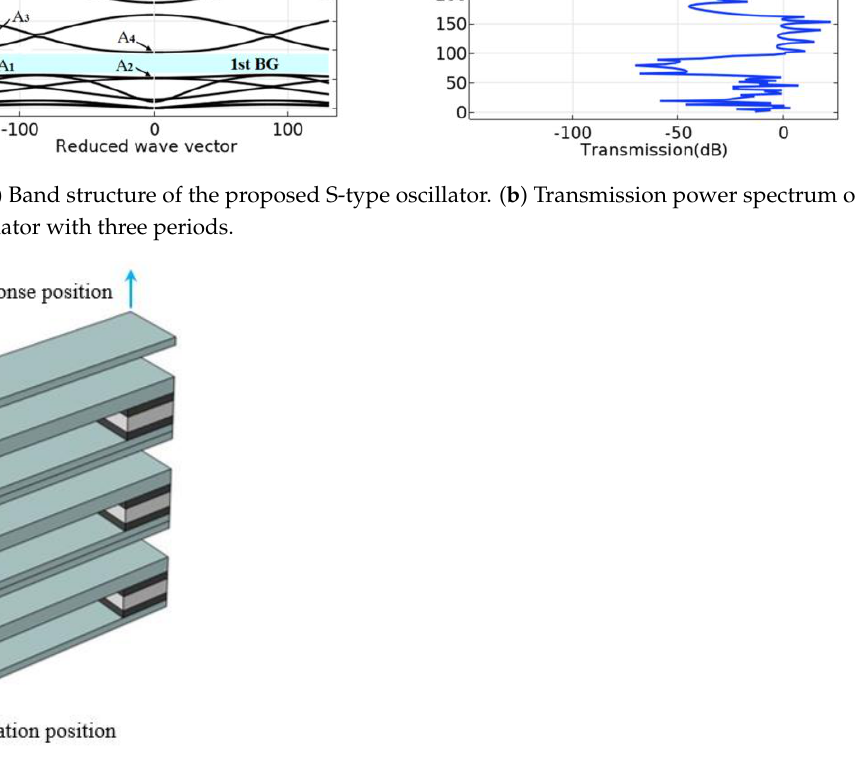
Figure 3. The oscillator structure model is formed by the periodic arrangement of 3 S-shaped unit cells.